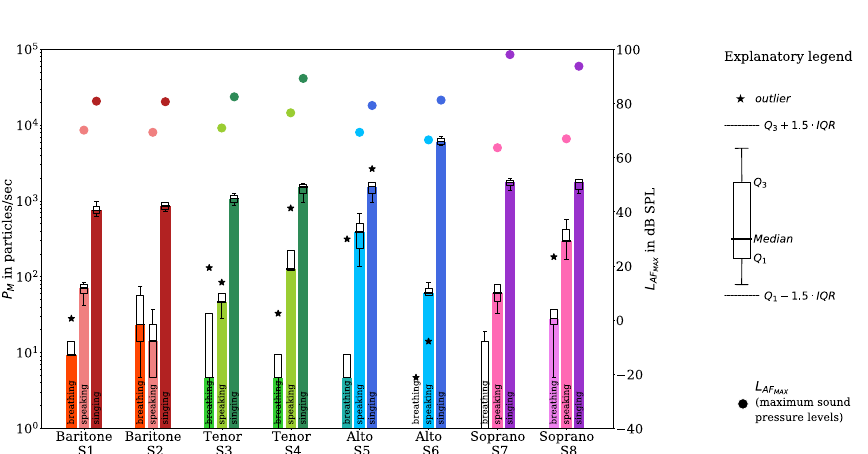
Figure 2. Boxplots of the emission rates (left y-axis; bars represent the median for all replications of each task) for the test conditions breathing, speaking, and singing (denoted by hue and labeled at the bars) and the different voice classifications (baritone (red), tenor (green), alto (blue), soprano (magenta), as denoted in the x-axis) in experiment I. The emission rates for all particle size classes are cumulatively summarized. The black-framed boxes extend from the lower ( Q 1) to upper ( Q 3) quartile values of the data, with a thick line at the median. The lower and upper whiskers represent data greater than Q 1 − 1.5 · ( Q 3 − Q 1 ) and lower than Q 3 + 1.5 · ( Q 3 − Q 1 ) , and stars denote outliers, respectively. For the test conditions speaking and singing, the median of the maximum sound pressure levels L AF MAX for all replications were denoted by full circles (values corresponds to the right y-axis). For breathing, the sound initiated by the technical equipment such as fans was higher than any acoustic sound expelled by the participants. Therefore, no L AF MAX are given. (Figure created with matplotlib 3.2.1, http:// matpl otlib.